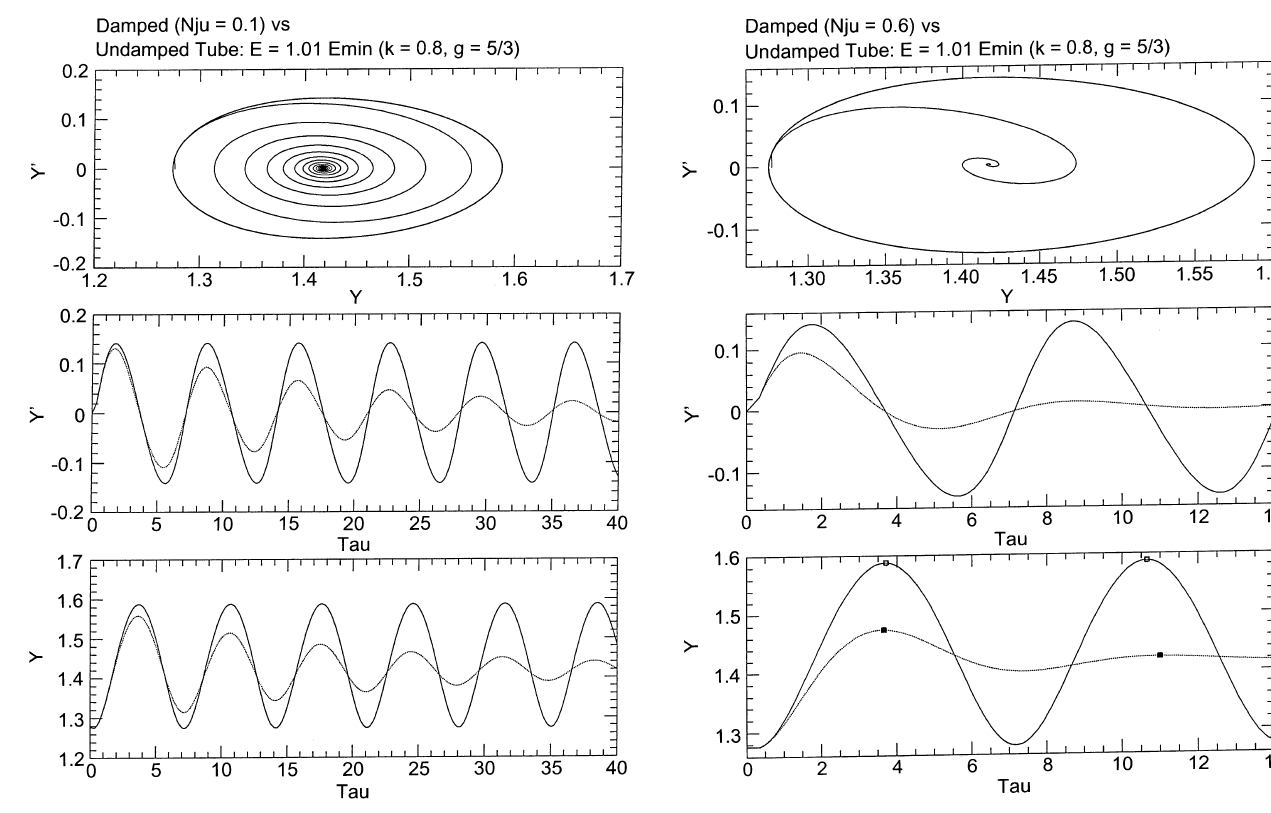
Fig. 9. A comparison of the small-amplitude oscillations of two flux tubes, one with damping ( dotted lines ) and one without ( solid lines ) in the same format as Fig. 8. The damping coefficient (cid:109) (cid:3) is = 0.1. The common parameters are (cid:106) (cid:136) 0 : 8 ; (cid:99) (cid:136) 5 = 3 and E (cid:136) 1 : 01